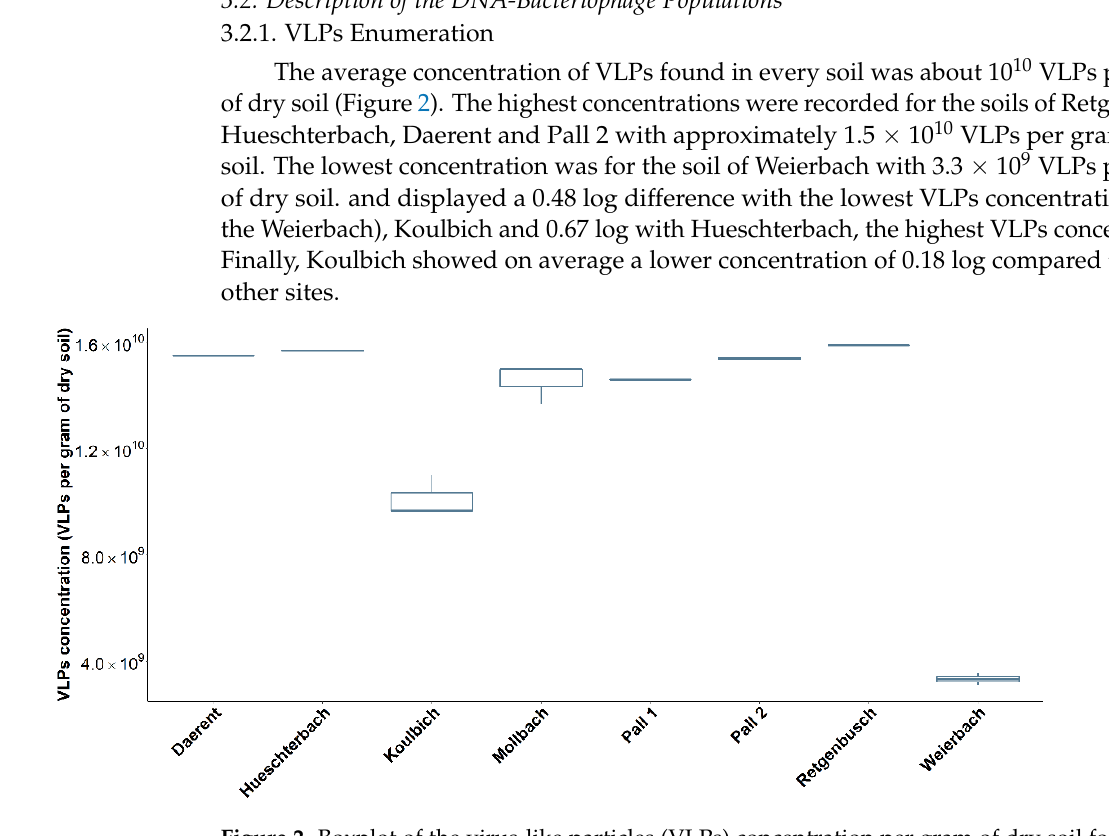
Figure 2. Boxplot of the virus-like particles (VLPs) concentration per gram of dry soil for all studied sites.